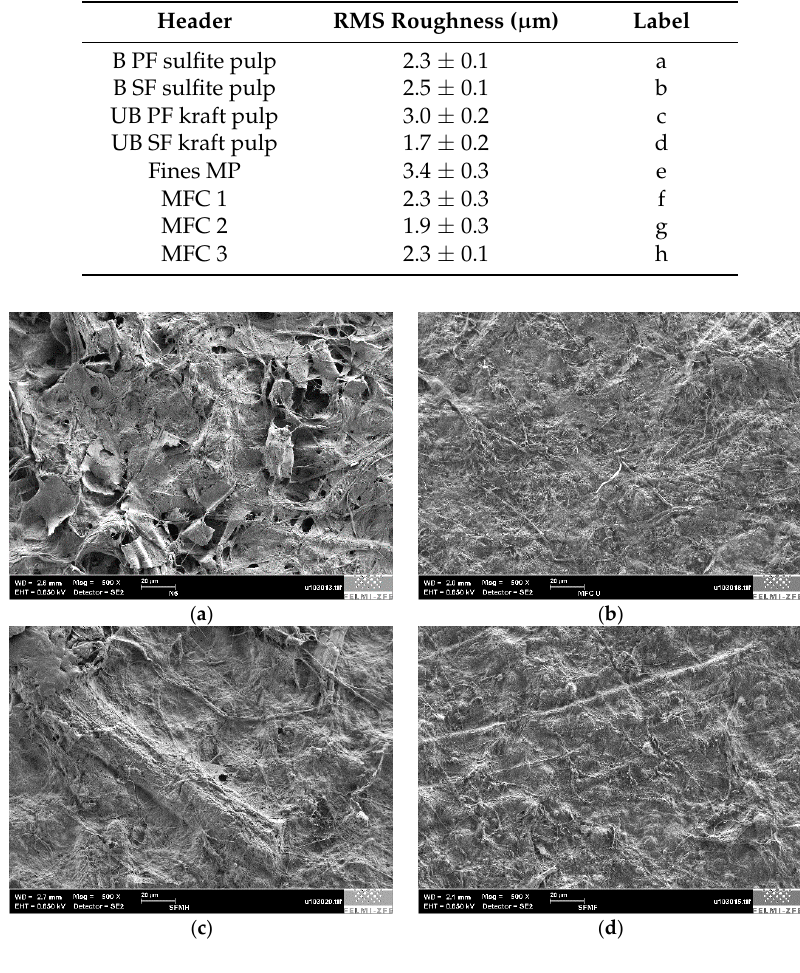
Figure 7. Low voltage scanning electron microscopy (LVSEM) images of sheets from different